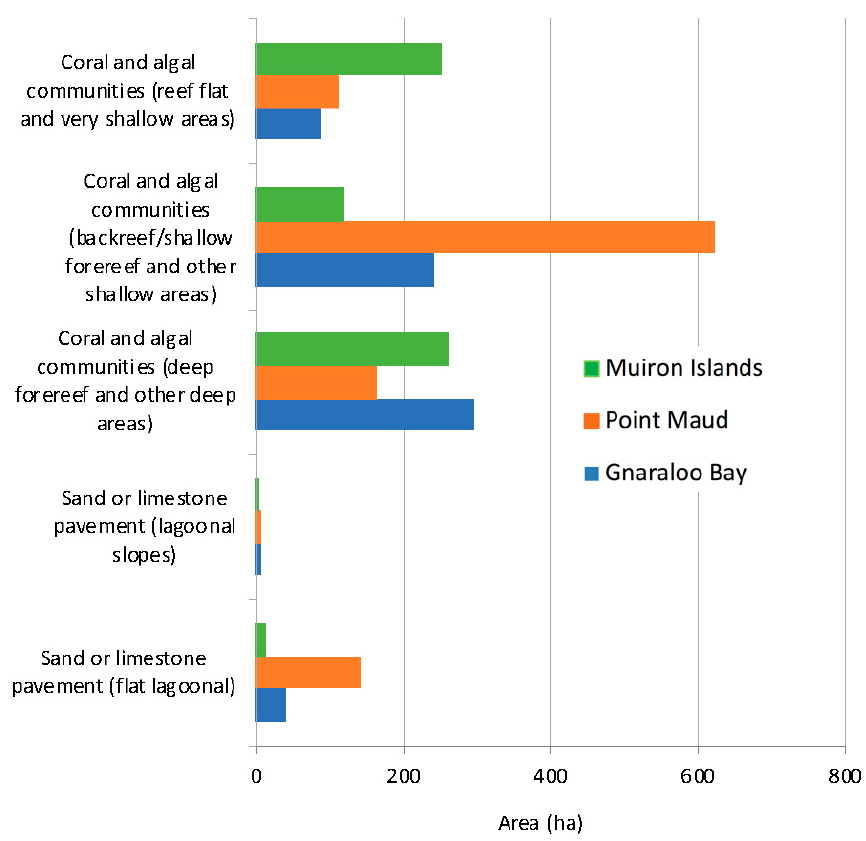
Figure 10. Summary of areas (ha) of geomorphic classes mapped within the three focus areas along the Ningaloo Reef.